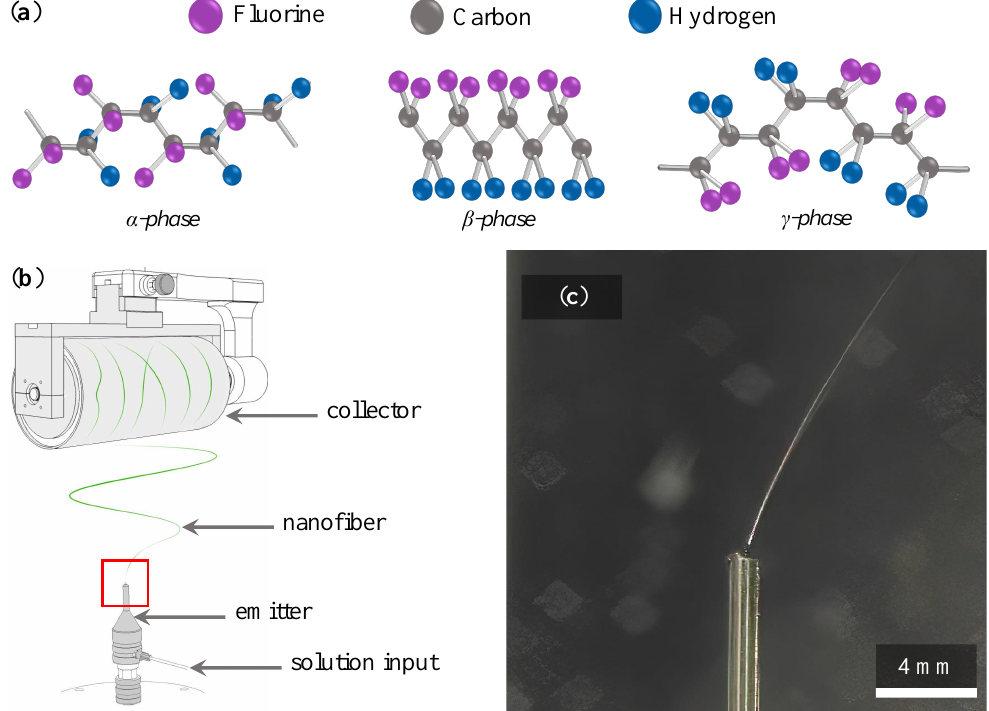
Figure 1. ( a ) Depiction of the chain conformation for the α -, β -, and γ -phase. ( b ) Illustration of electrostatic spinning using the single needle as the emitter, and the solid continual cylinder as the collector. The collected fiber is highlighted in green here (the actual color of the fiber depends on the fillers used—for example, the addition of carbon nanotubes is a dark black fiber, the addition of bismuth ferrite is a red fiber). ( c ) Detail of the polymer jet withdrawn from needle by applied high